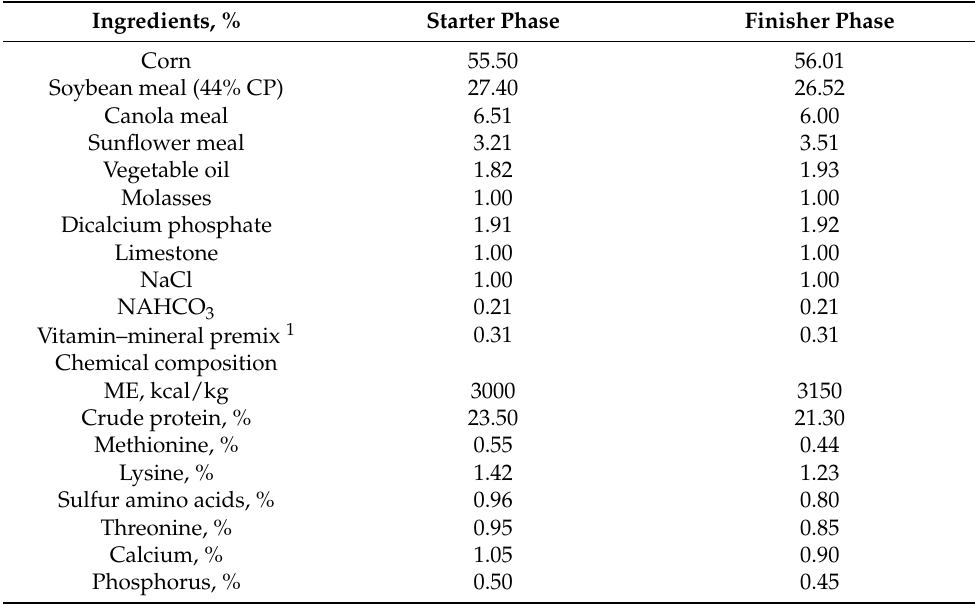
Table 1. Composition and chemical composition of the basal diets.